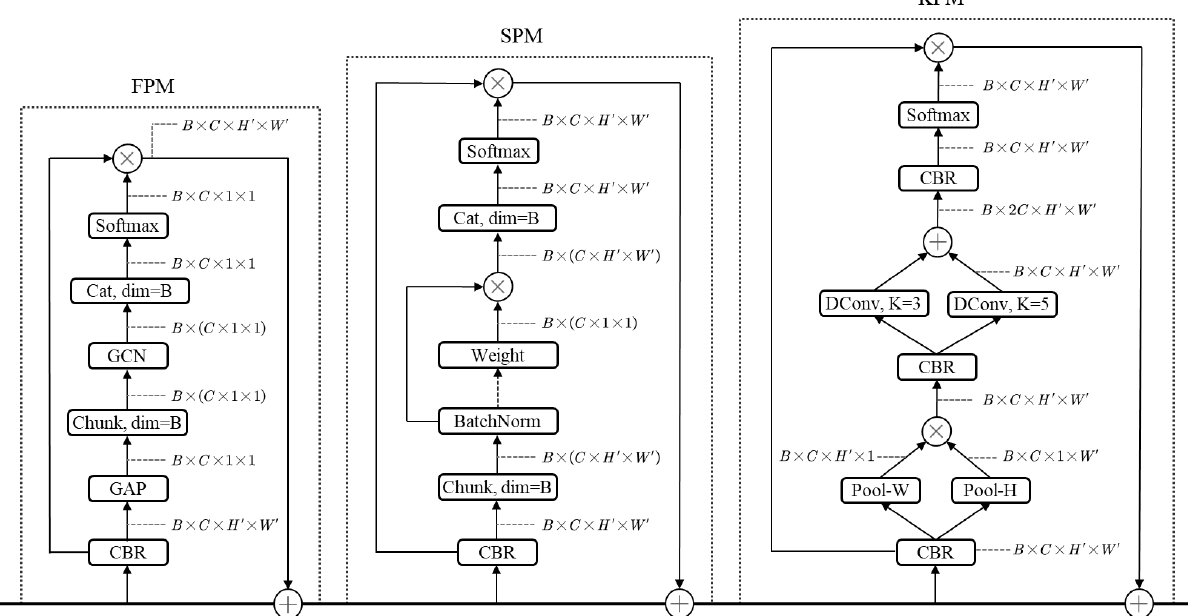
Figure 5. Ternary cascade perception module (TCPM)